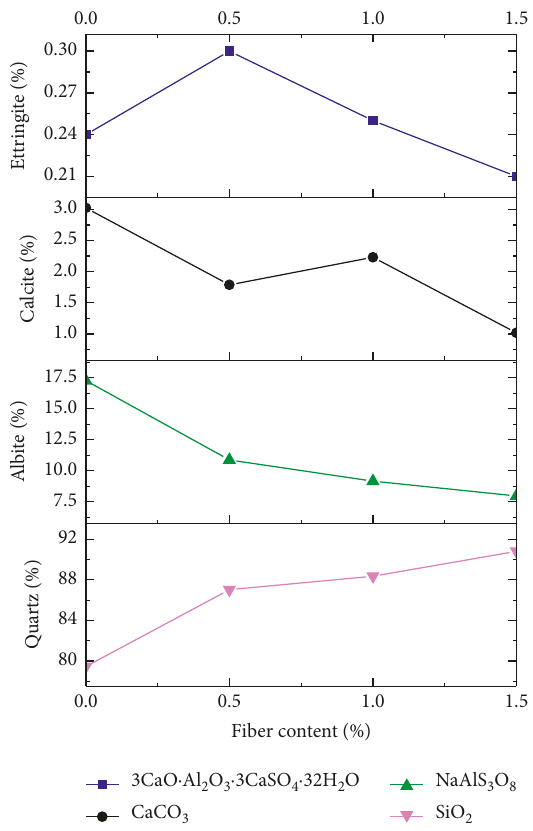
Figure 7: Content variation curves for four primary components with fiber content.